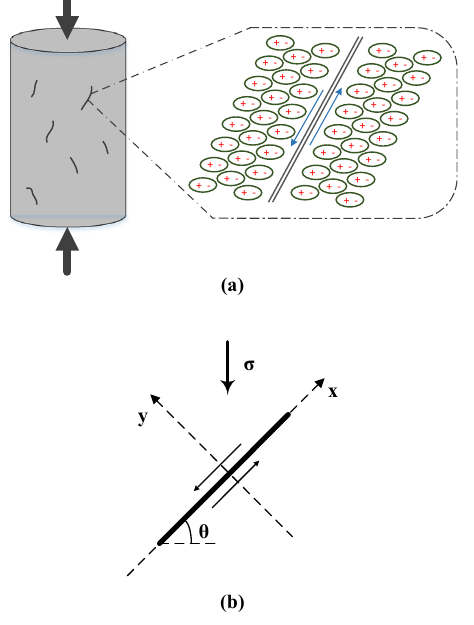
b Fig. 11 The charge signal spectrum excited in different compression phase. a Compaction phase, b Elastic phase, c Strengthen phase, d Post-peak phase